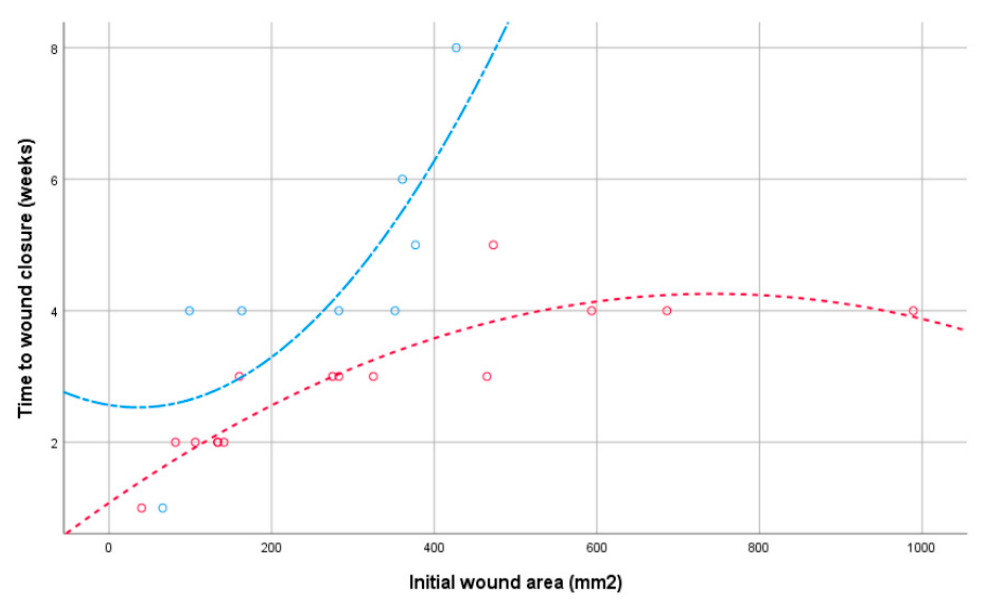
Figure 4. Distribution of wound healing times by initial wound area: patients without breast cancer (red line) and patients with conservative treatment for breast cancer (blue line).